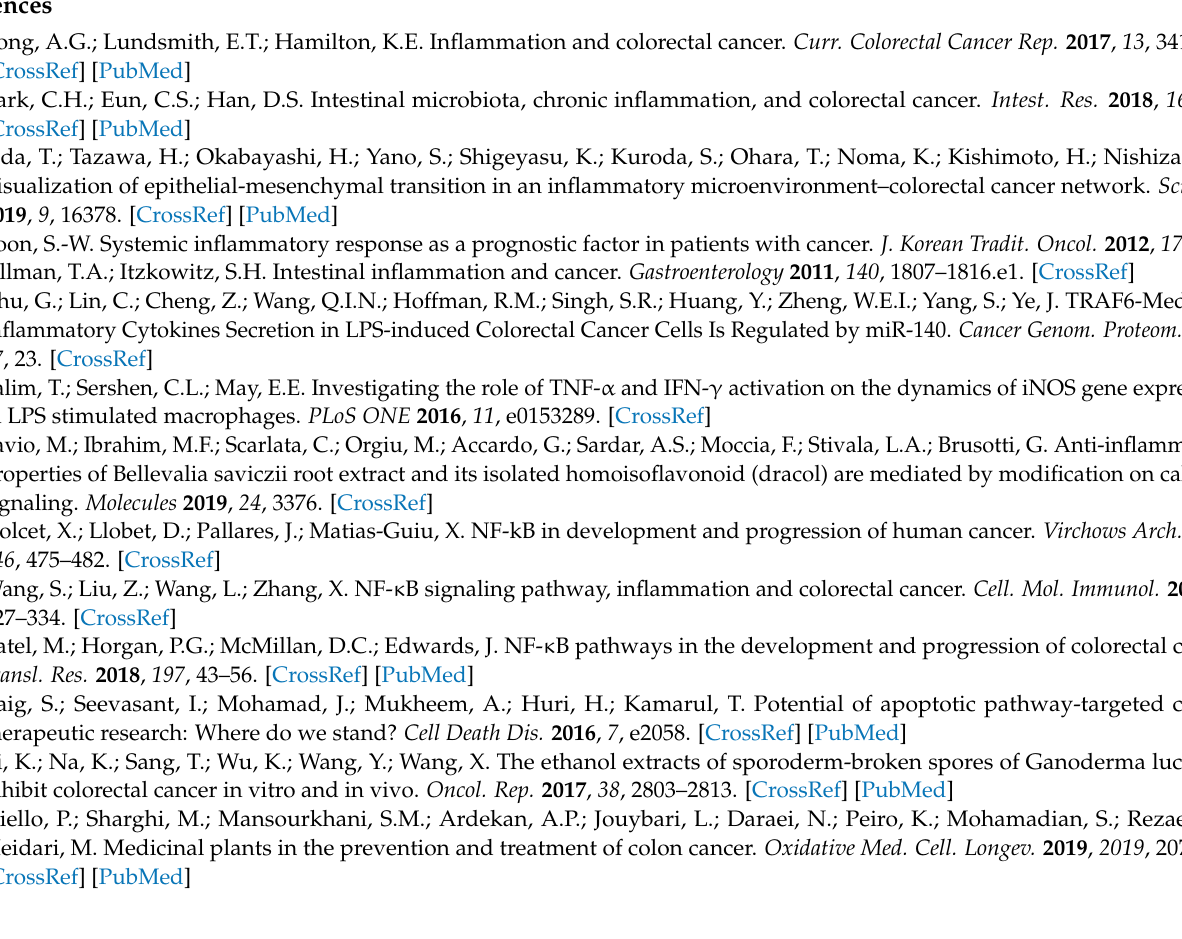
Table S4: The % relative change of proteins related to cell proliferation in HCT-116 and HT-29 human colorectal cancer cell lines by FDLE, Table S5: The % increasing of apoptosis in HCT-116 and HT-29 human colorectal cancer cell lines by FDLE, Table S6: The % relative change of proteins related to apoptosis in HCT-116 and HT-29 human colorectal cancer cell lines by